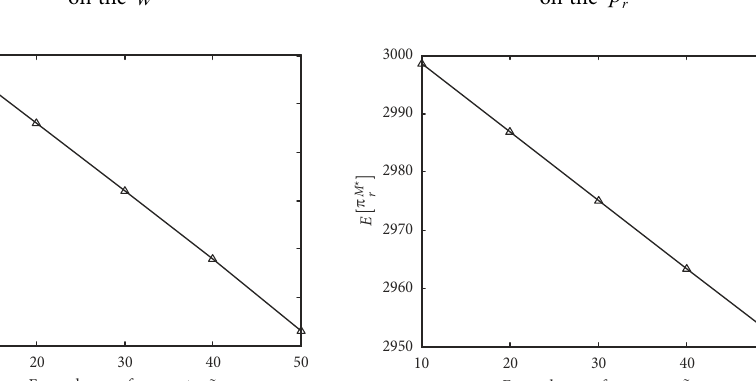
Figure 2. Information asymmetry’s impact on the